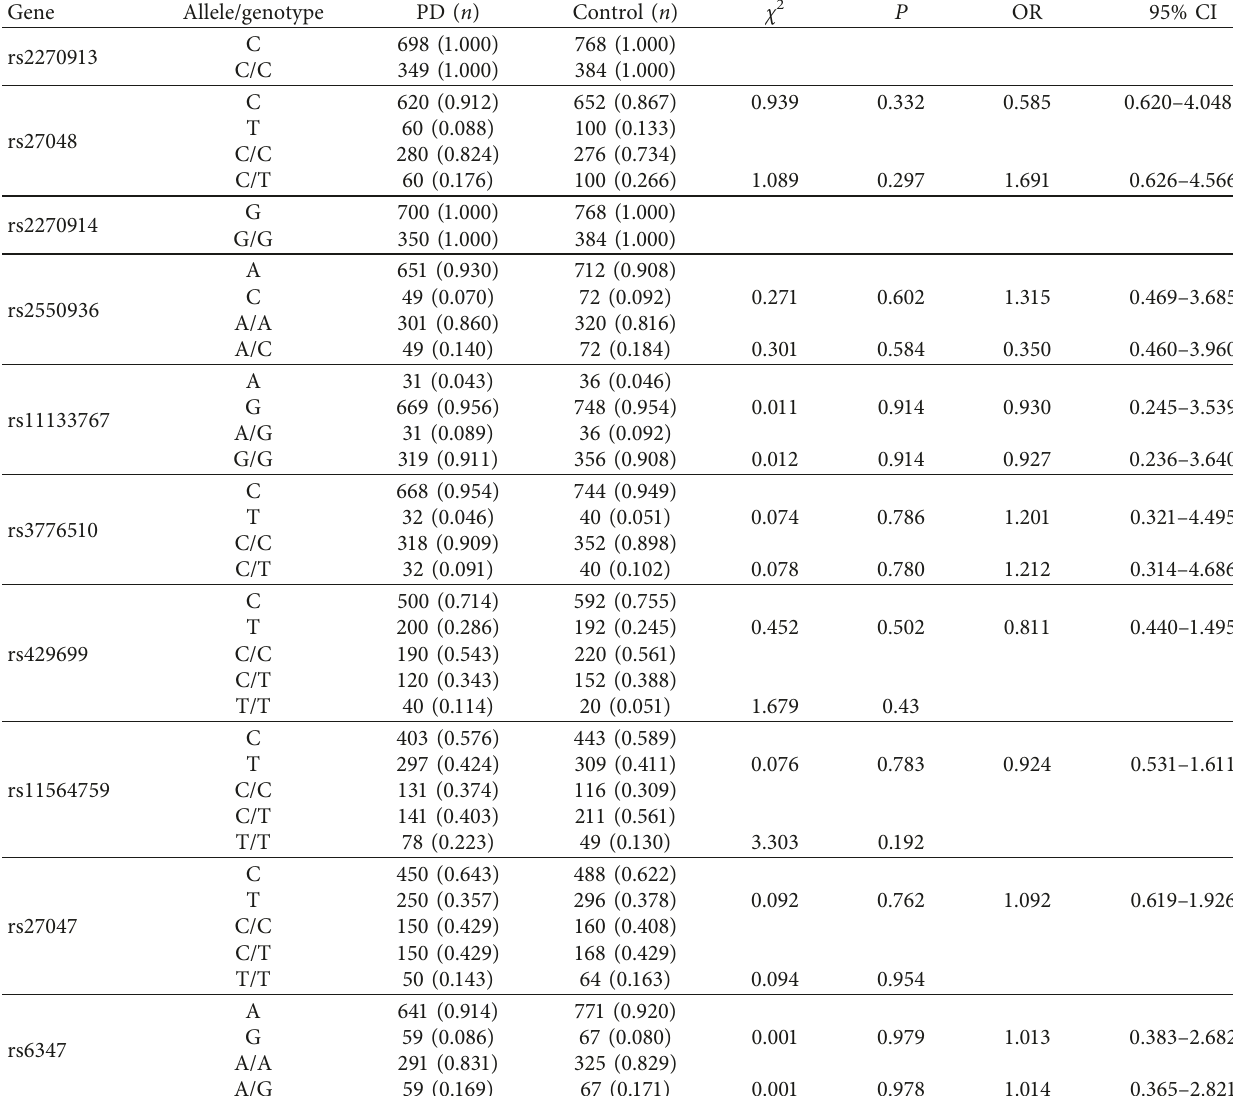
Table 3: Frequency distribution of SLC6A3 genotypes and